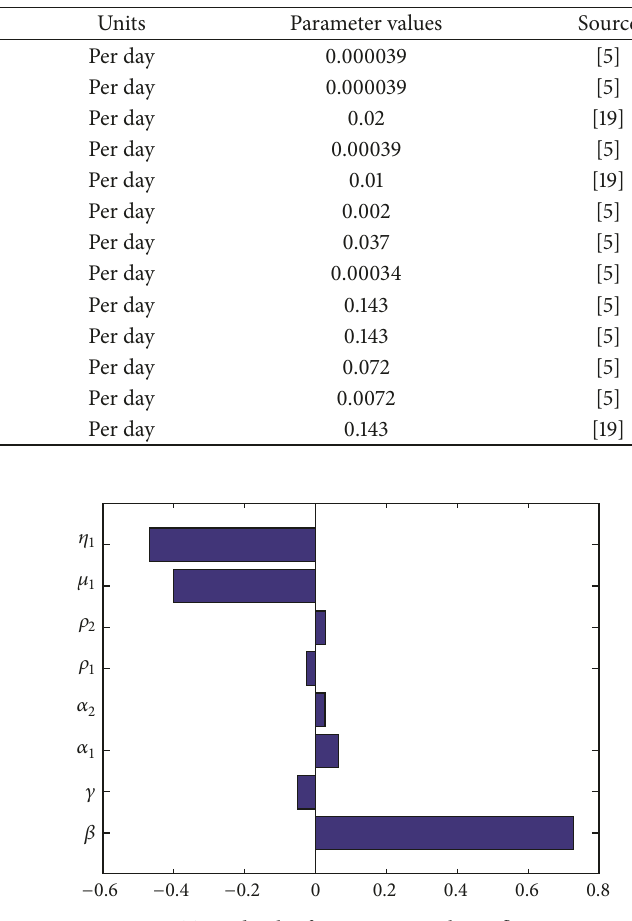
Figure 3: Tornado plot for parameters that influence 𝑅 0